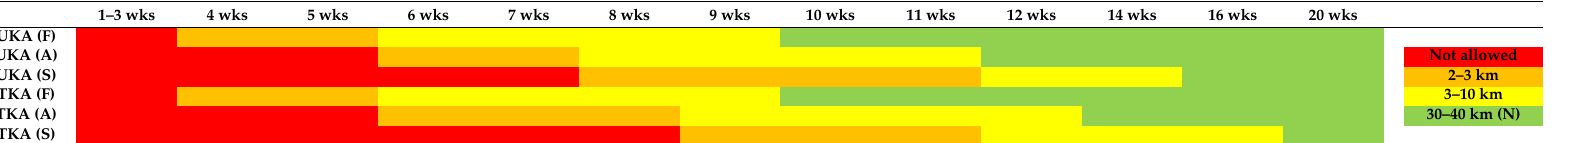
Table 2. Recovery recommendations for “cycling” for all six groups, i.e., three recovery rates for UKA and